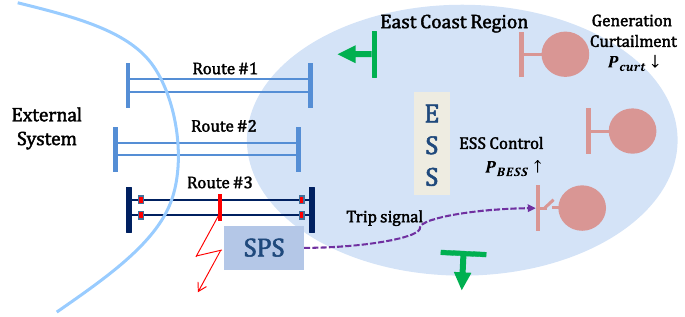
Figure 3. East coast region in the Korean power system .